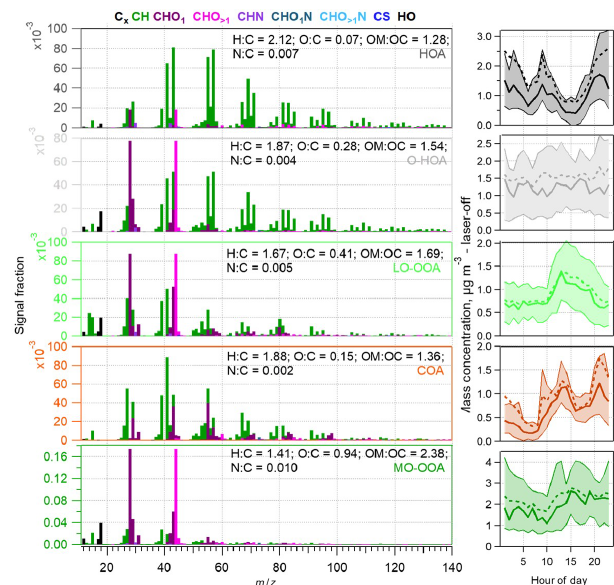
Figure 3. (a) Mass spectra and elemental ratios of the five-factor solution obtained from the PMF analysis of laser-off measurements and (b) their respective diurnal cycles (the median is shown using the plain line, the mean is shown using the dotted line, and the 25th and 75th percentiles are shown using the shaded area) for the entire campaign. The PMF results from laser-on measurements are shown in Fig.